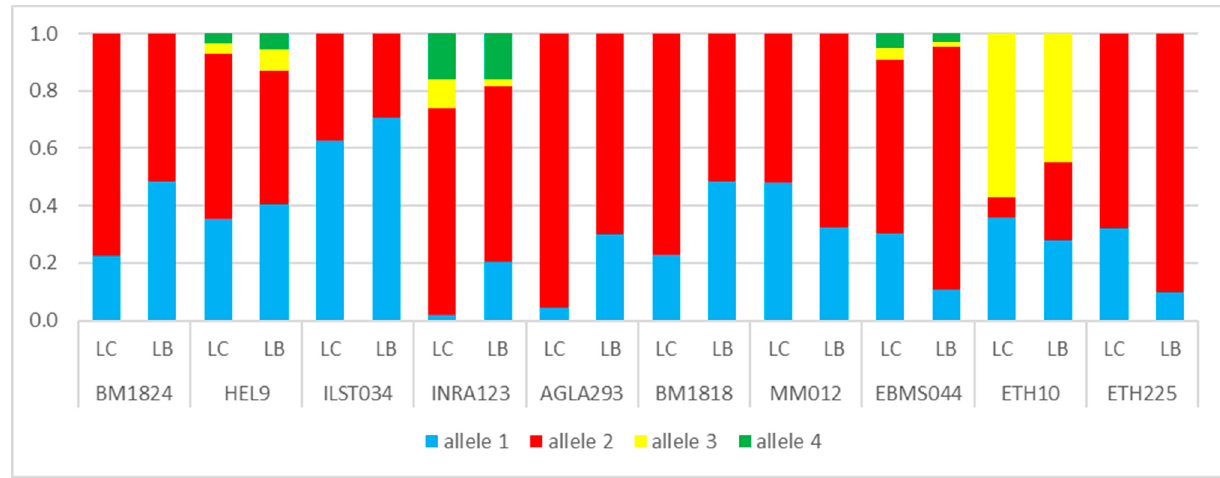
Figure 2. Frequency of alleles within all 10 loci and two genetic lines (LC and LB). Table 3. Genetic parameters of Lowland–Caucasian (LC) and Lowland (LB) lines. LC Line LB